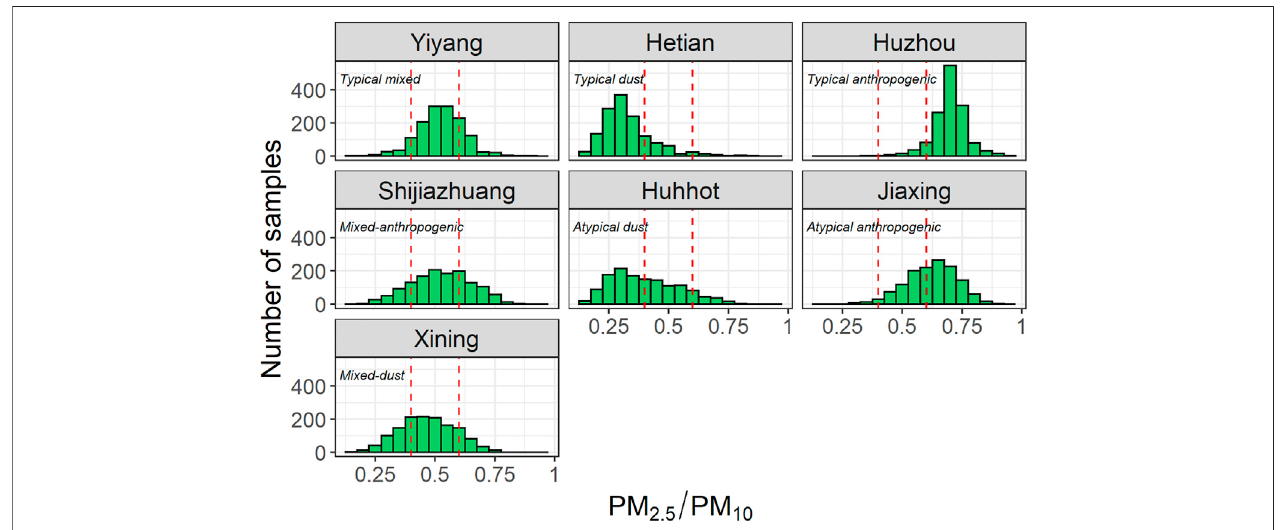
FIGURE3 | Schematic PDF distribution ofPM 2.5 /PM 10 ratiosfor seven types ofurban pollution. The red dotted lines indicate the PM 2.5 /PM 10 ratios of0.4 and 0.6, respectively.